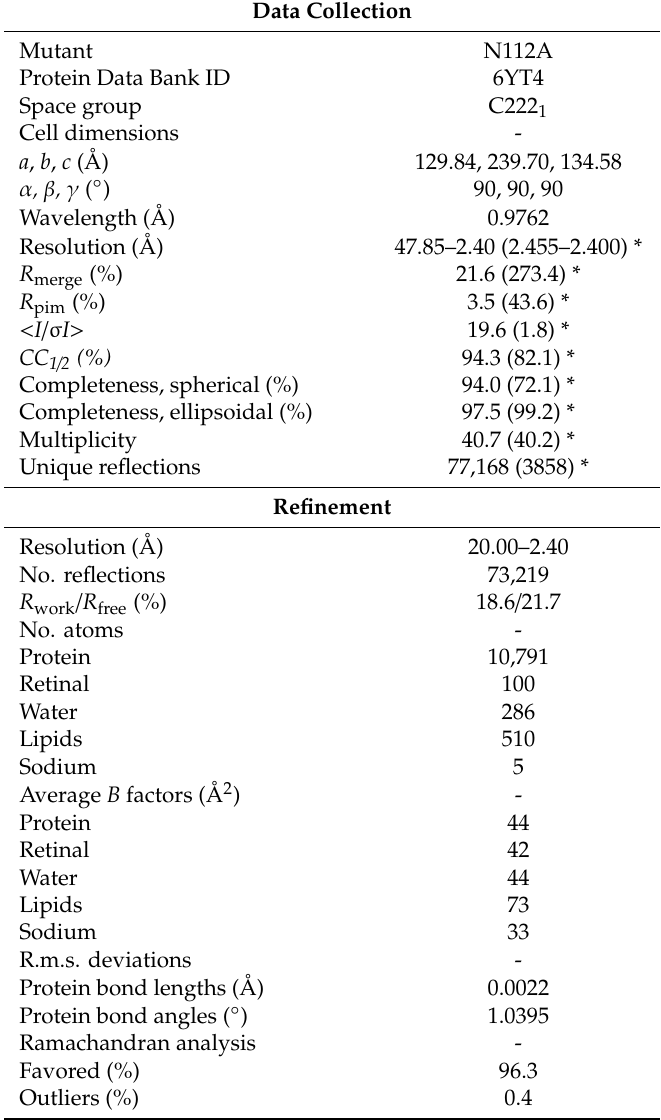
Table 1. Crystallographic data collection and refinement statistics. R.m.s.: root mean